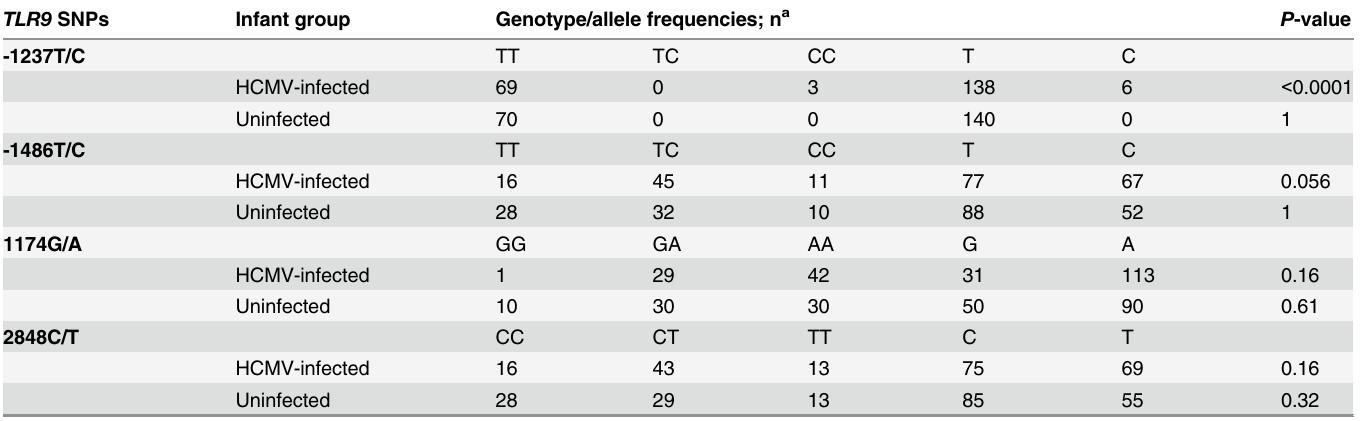
Table 4. TLR9 SNP variance from Hardy-Weinberg equilibrium.